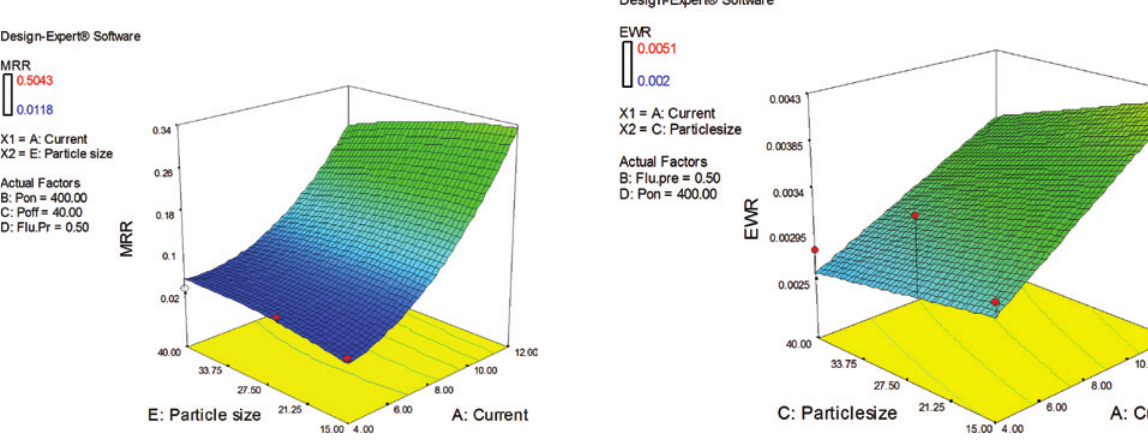
Figure 5 Interactive effect of current and particle size on MRR.